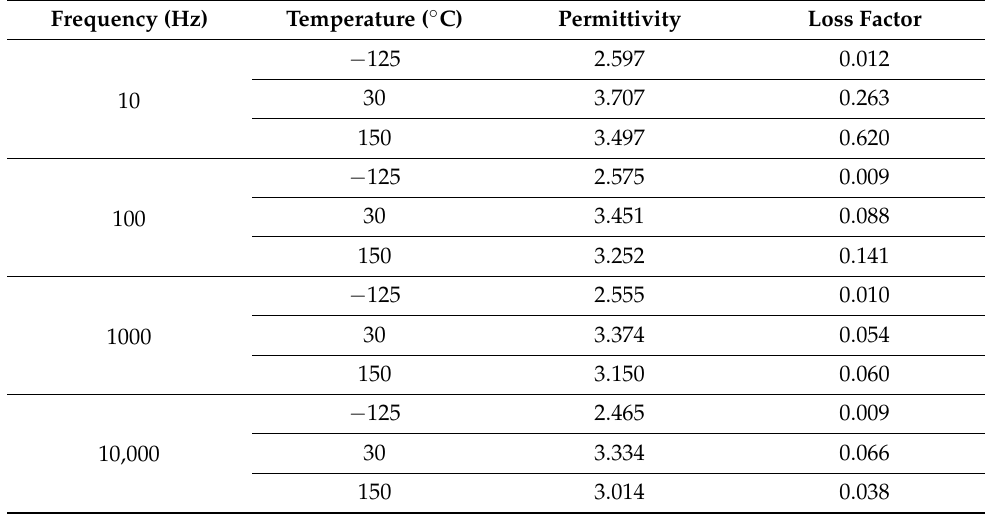
Table 5. Permittivity and loss factor of cured resin at 10, 100, 1000 and 10,000 Hz, and − 150, 30 and 150 ◦ C, at BP:B10 = 2:1 (anisotropic).